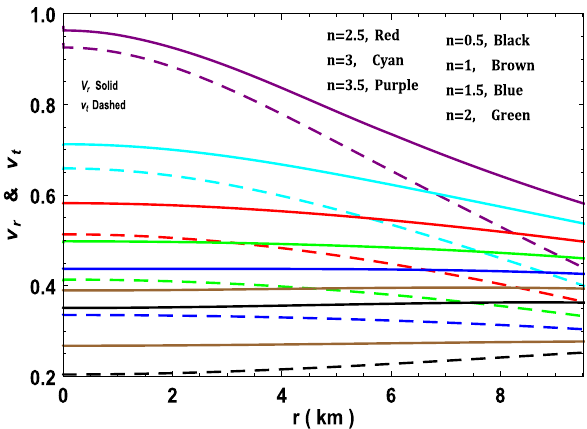
Fig. 13 Variation of sound speed with radial coordinate r for 4U 1608- 52 ( M = 1 . 74 M (cid:9) , R = 9 . 528 km) by taking a = 0 . 001 km − 2 and β = 0 . 01